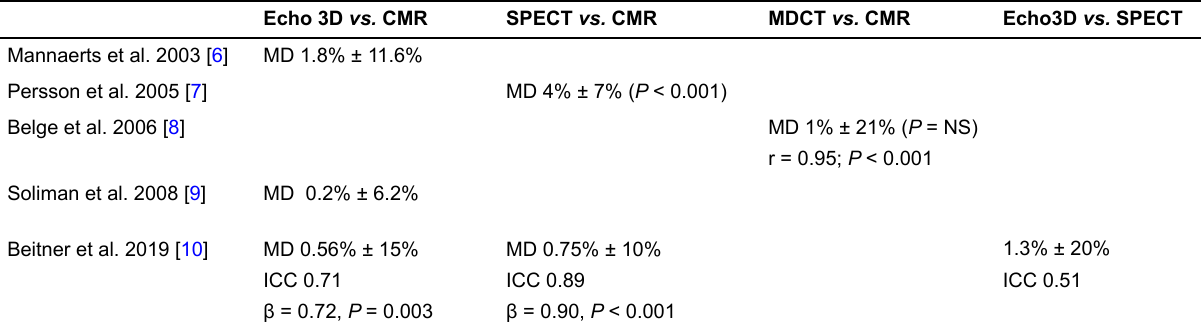
Table 1. Comparison of LVEF as measured by different non-invasive imaging methods, reported mean difference and agreement Echo 3D vs.